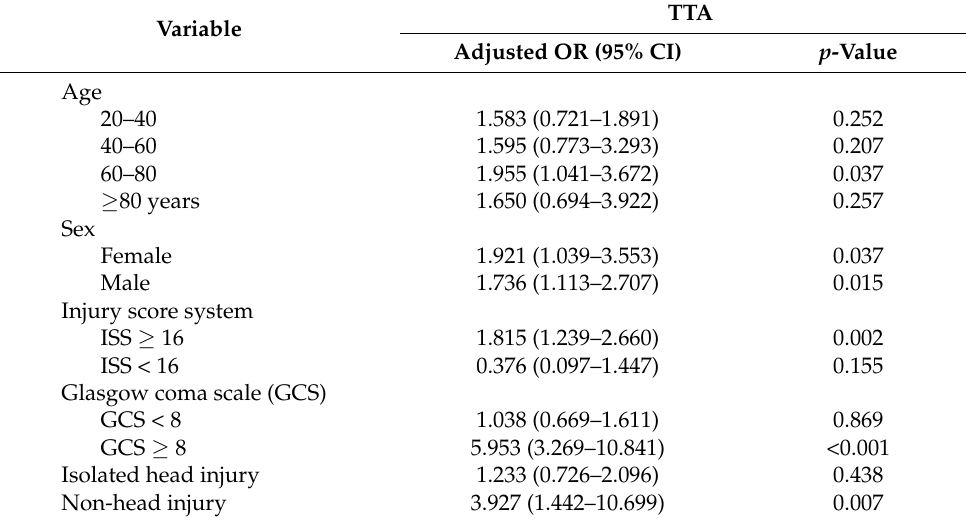
Table 4. Multivariable logistic regression of in-hospital mortality in subgroup analysis.